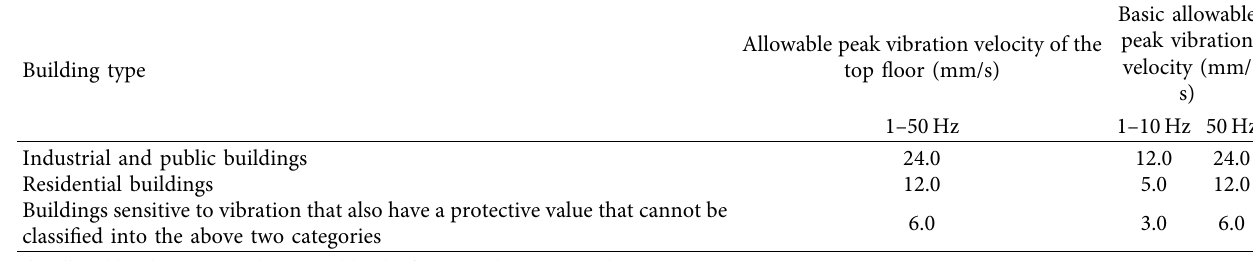
Table 2: Allowable vibration of the architectural